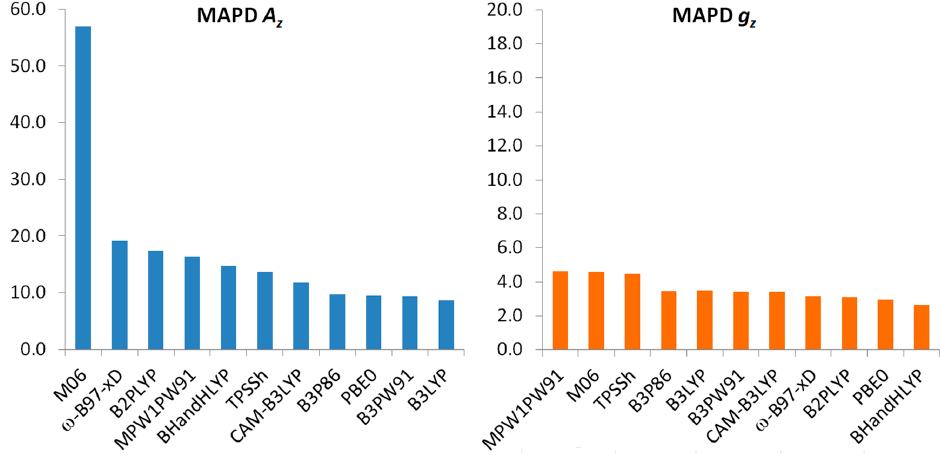
Figure 2. Mean absolute percent deviation (MAPD) from the experimental values of A z ( left ) and g z ( right ) determined with the eleven functionals on the fourteen Cu(II) complexes included in the dataset.